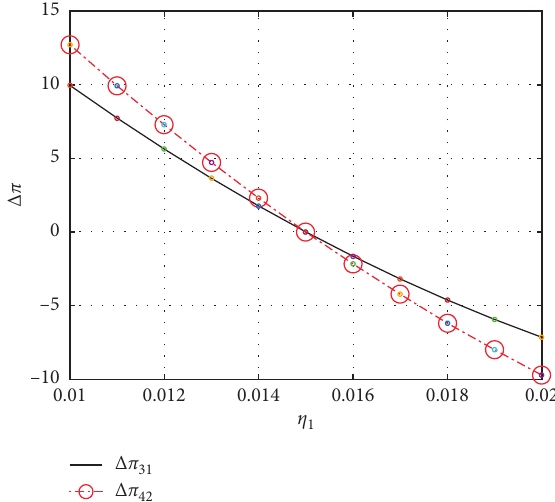
Figure 4: The incremental value of an interactive fashion over experiential services ( Δ π ) and the incremental value of design 42 ), plotted as a function of efforts over the traditional system ( Δ π 31 the deterioration rate of fashion level, η 1